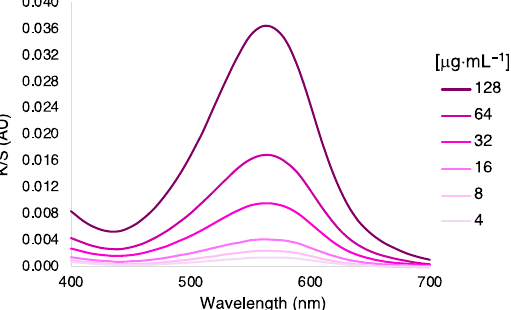
Figure 6. K/S spectra of silk fabrics dyed with AzoIz.Pip in different concentrations at pH 6 and immersed in a Britton–Robinson solution at pH 10. Table 7. K/S, ∆ E, and UPF values of the dyed silk samples with di ff erent concentrations of AzoIz.Pip under pH 6 and 40 °C and immersed in a Bri tt on–Robinson solution at pH 10.